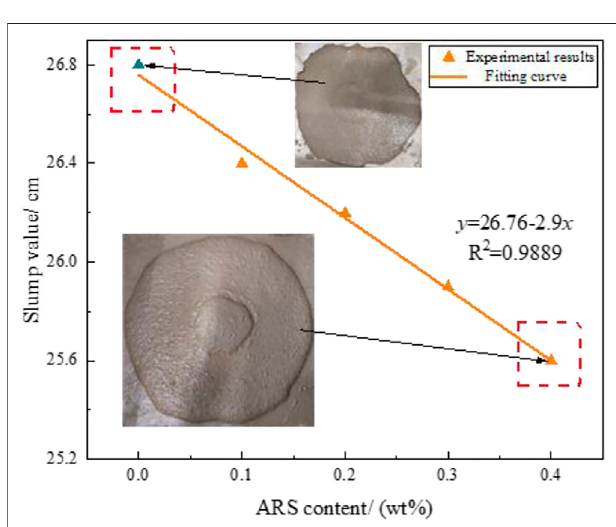
FIGURE 3 | Slump value of fi lling slurry.